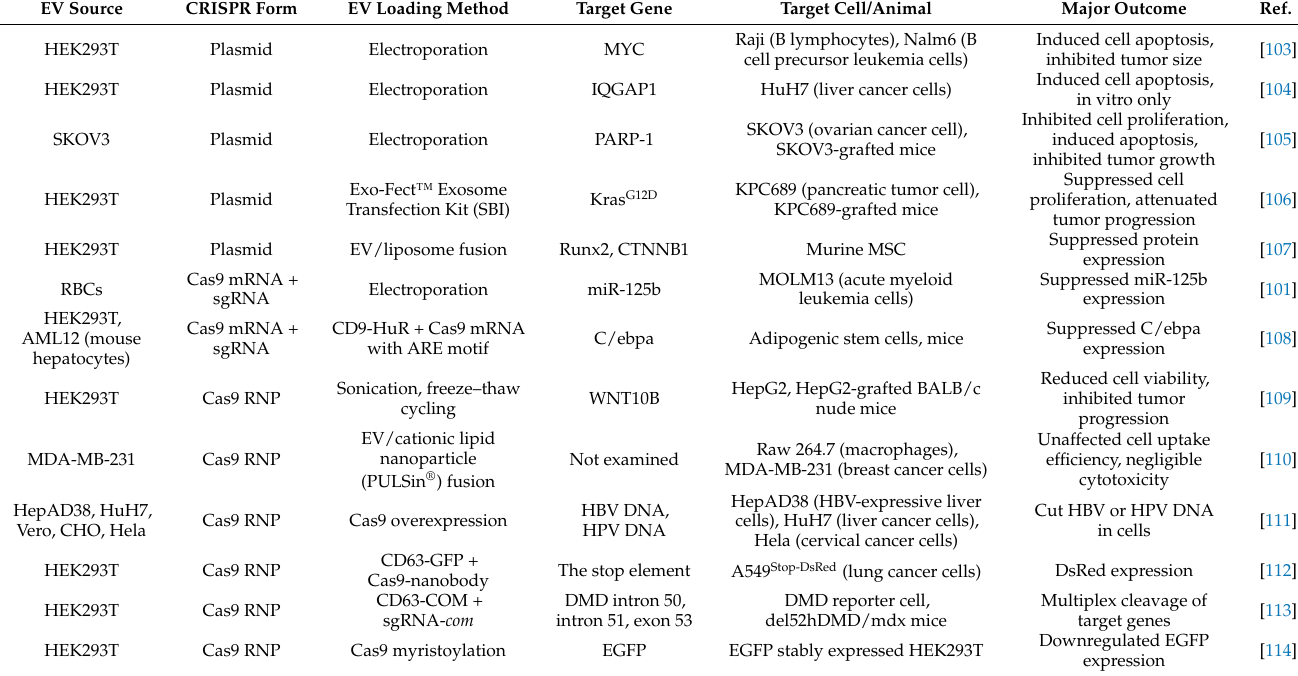
Table 1. Summary of EV encapsulation of CRISPR for gene editing in vitro and in